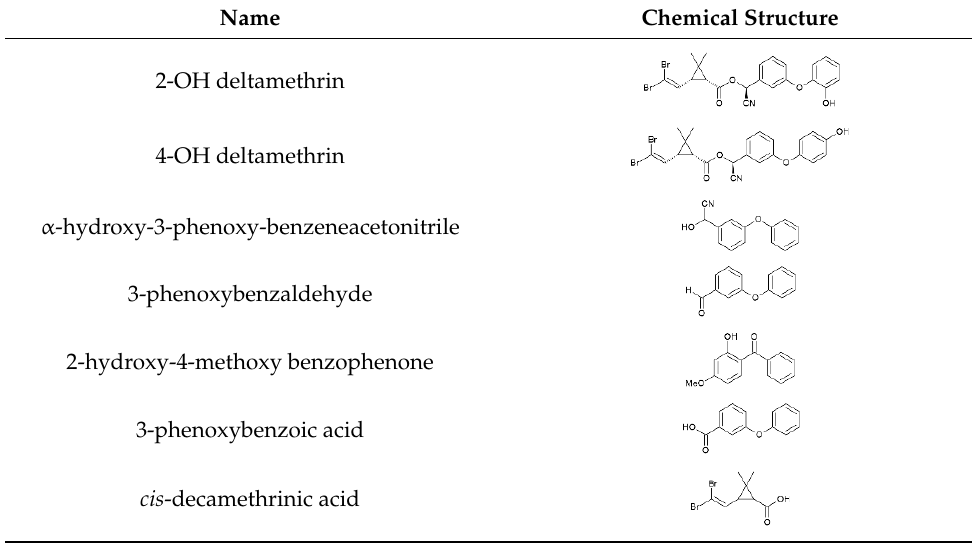
Table 1. DLM degradation products reported in the literature.